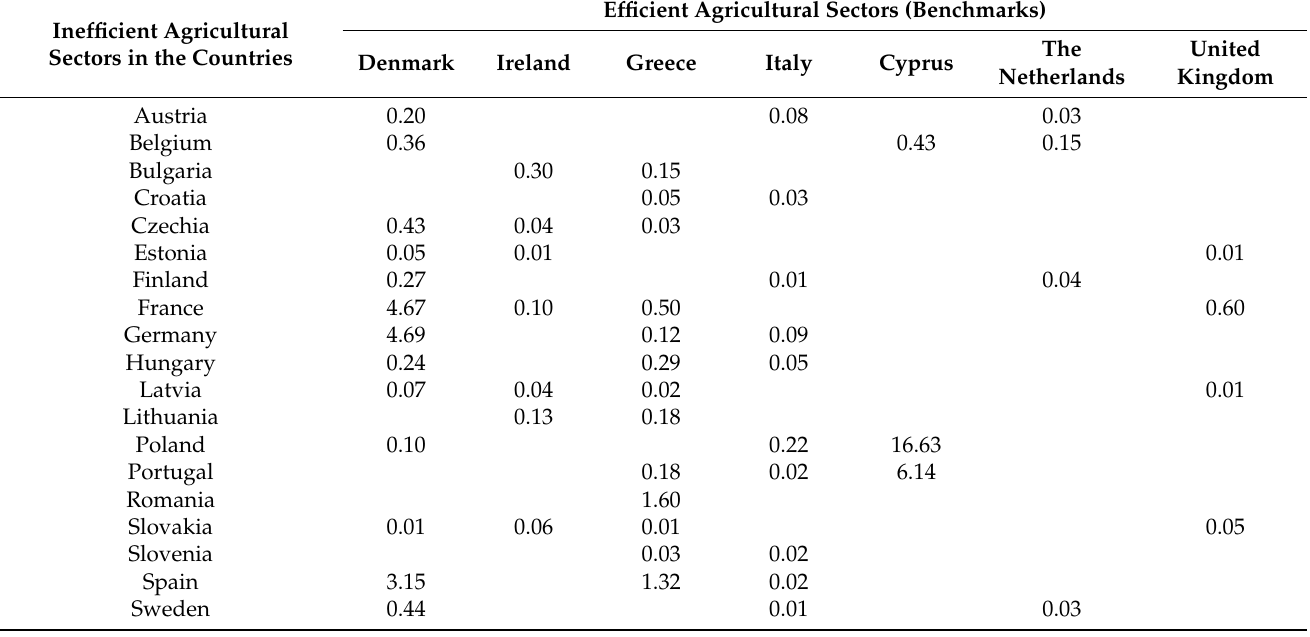
Table 4. The values of coefficients of the linear combination ( λ ) of common technology for agriculture in particular EU Member